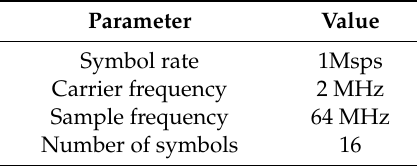
Table 1. Modulation